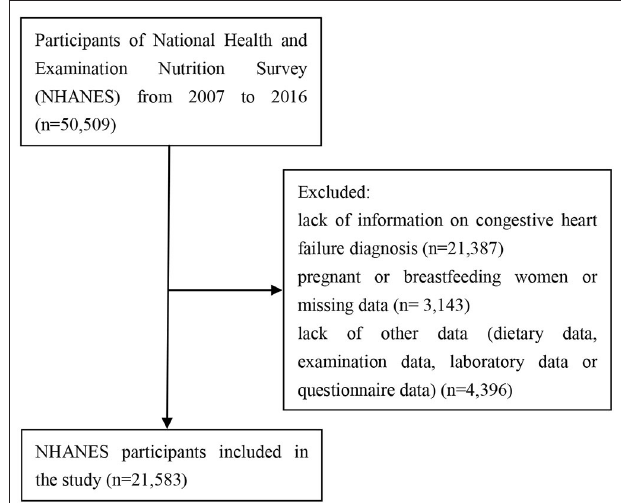
FIGURE 1 | Flowchart for participant selection.